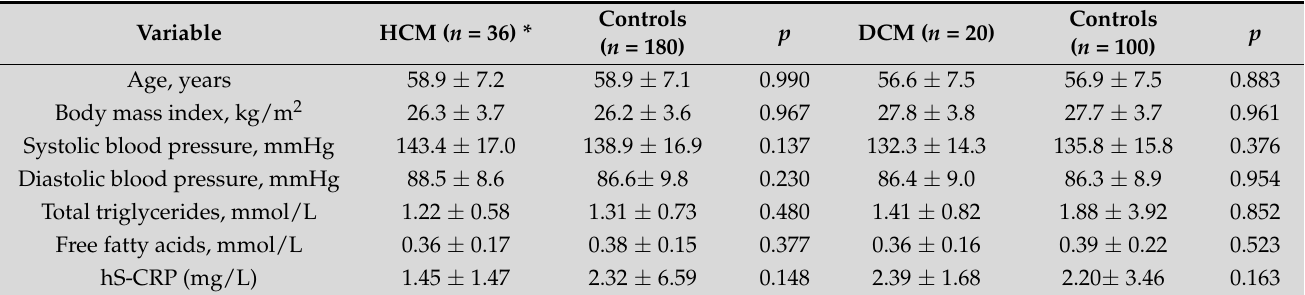
Table 1. Clinical and laboratory measurements in the participants with HCM and DCM and corre- sponding controls.